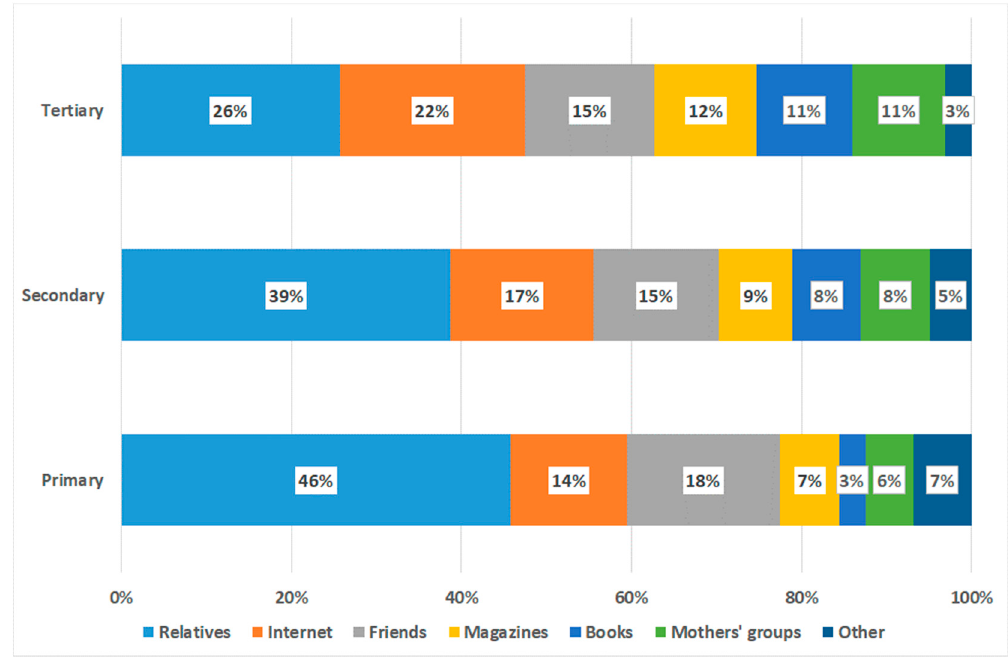
Figure 7. Other sources of information for mothers, according to women’s levels of education.